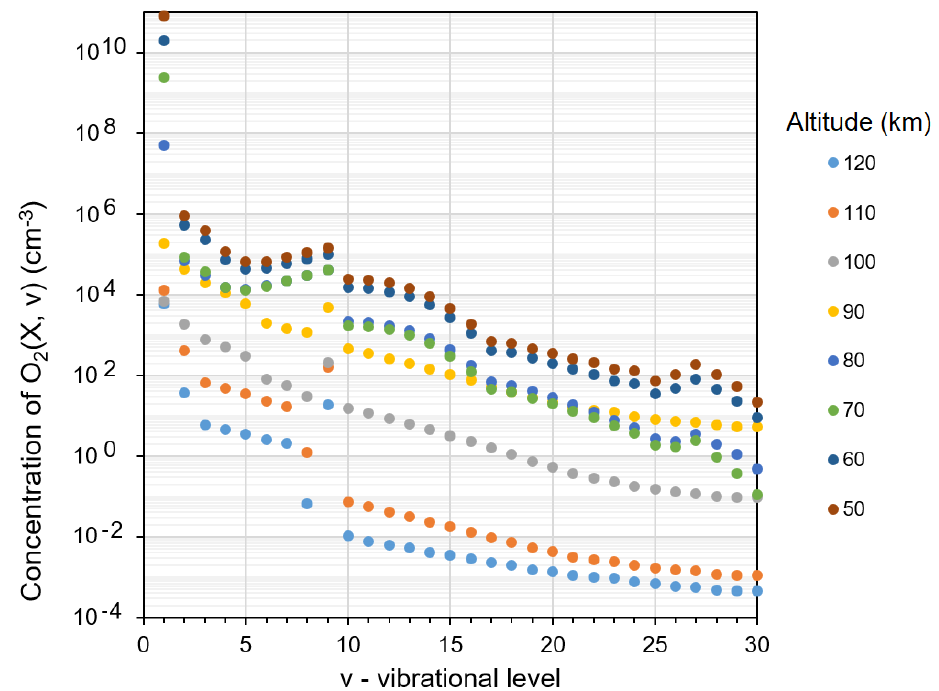
Figure 10. Population of O 2 (X 3 Σ − g , v = 1–35) levels for altitude from 50 to 120 km. Calculation using YM2011 model for TIMED-SABER event (37_01468), Date 16.03.2002, Lat = 43.3, SZA = 50.0.